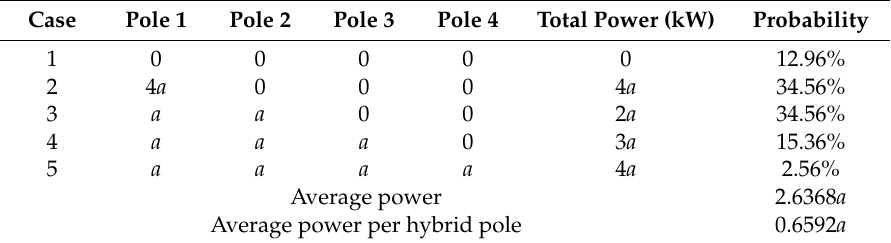
Table 6. Average power of 4 hybrid poles under the condition of binomial distribution. Case Pole 1 Pole 2 Pole